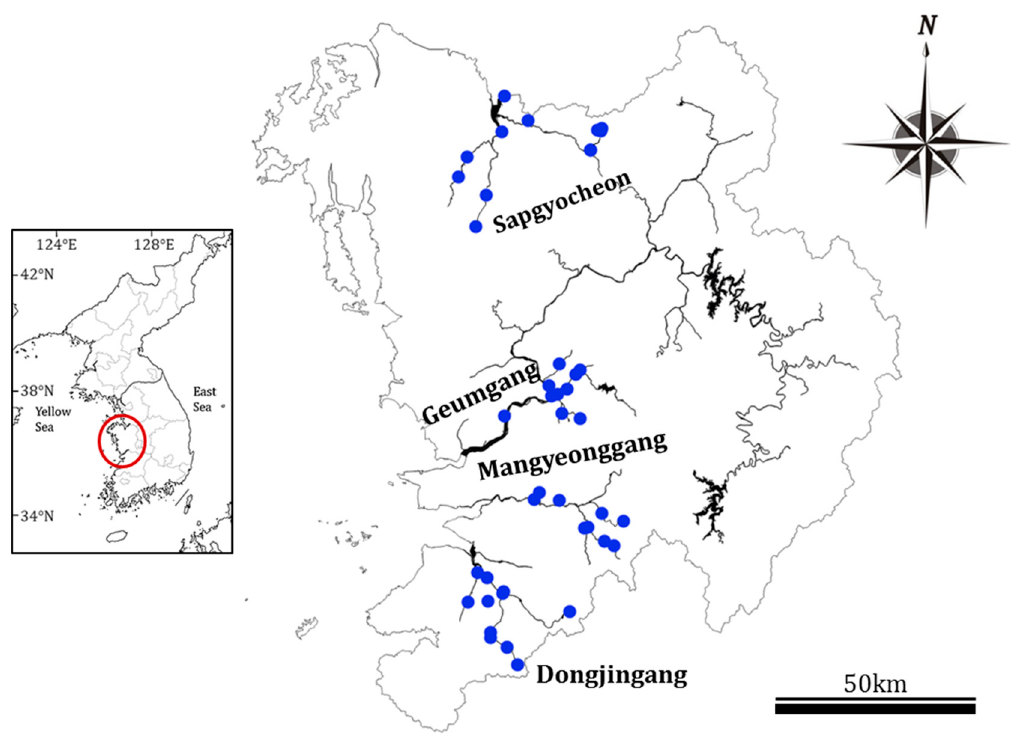
Figure 1. Location of the 42 sampling sites in four central western major streams of the Korean Peninsula. Aquatic environmental factors and diatoms were sampled twice a year from 2013 to 2015 (Geumgang; Geumgang River, Mangyeonggang; Mangyeonggang River, Dongjingang; Dongjingang River, Sapgyocheon; Sapgyocheon stream).